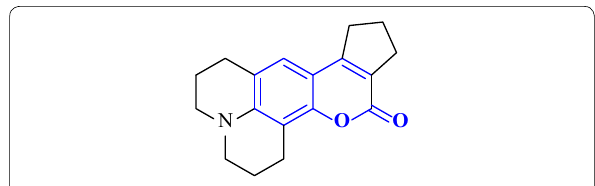
Fig. 4 Molecular structure of coumarin 106 or C1